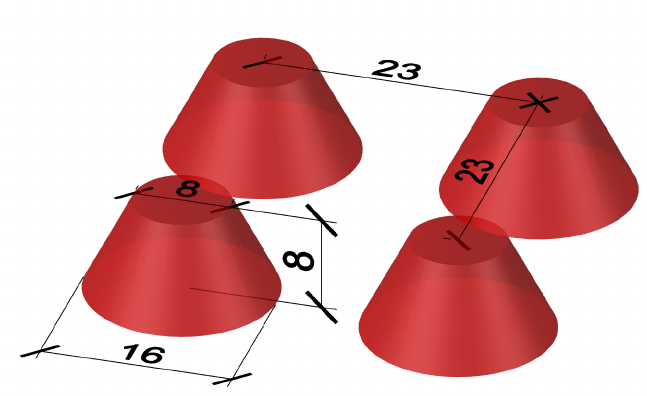
Figure 2. UHPC protrusions made by button